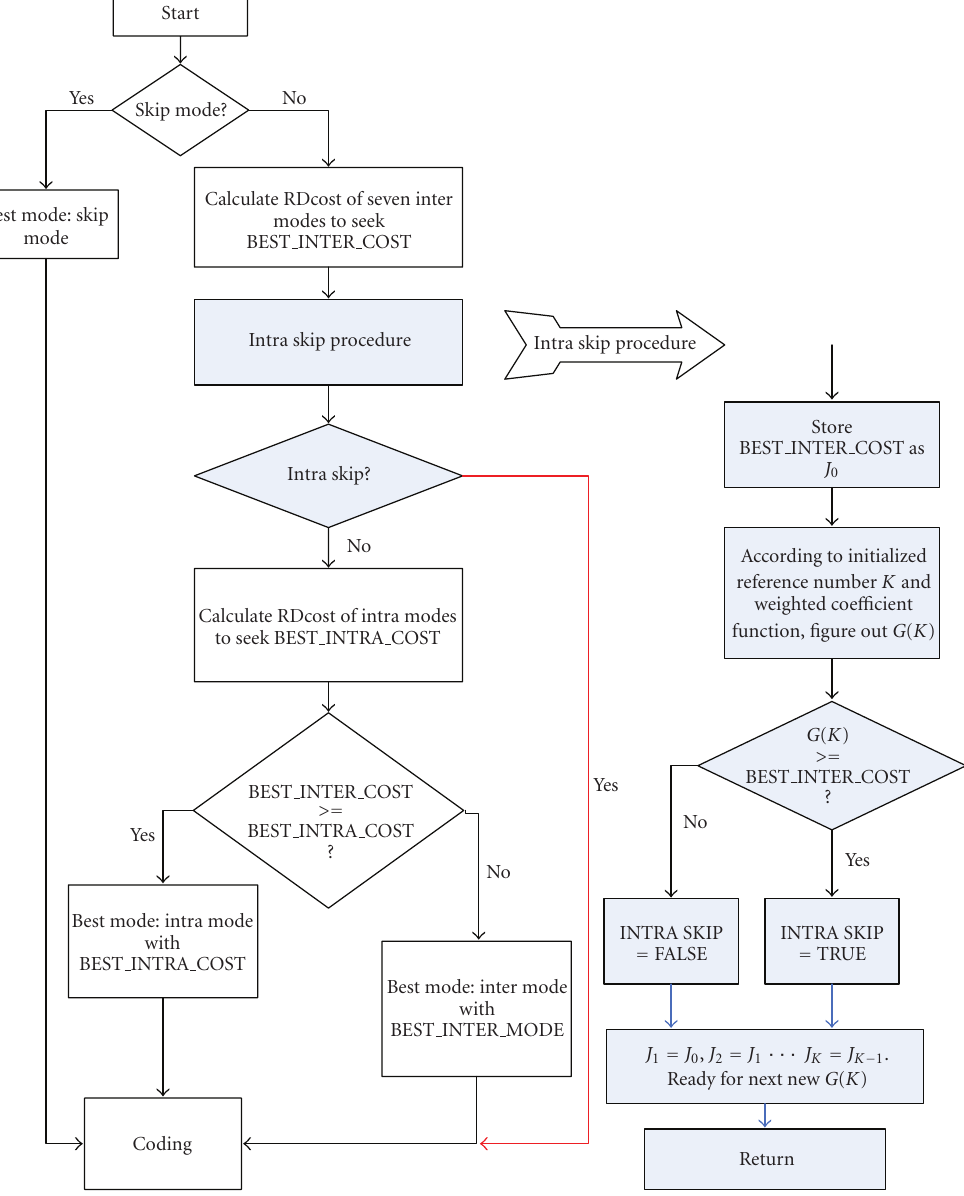
Figure 2: Flowchart of inter-frame coding with